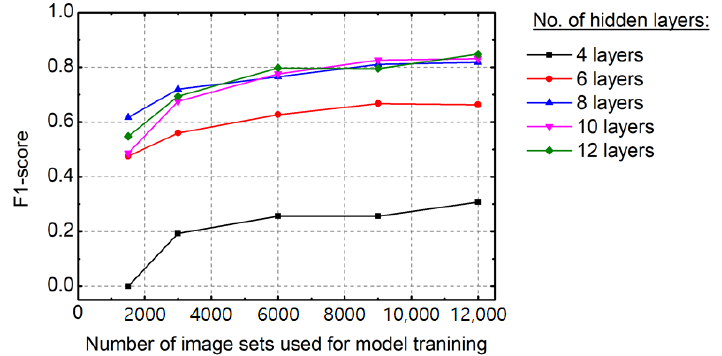
Figure 5. F1-score with different hidden layers and the number of model training images set.